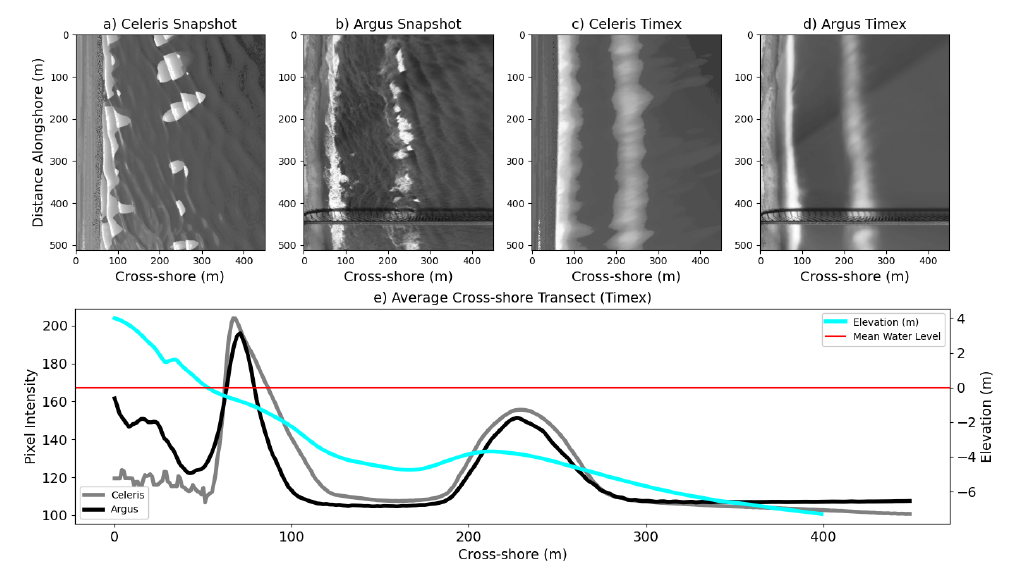
Figure 2. Comparison between synthetic imagery and HD video capture of the surf-zone. ( a ) Example snapshot of a Celeris visualization. ( b ) Example snapshot of the HD video. ( c ) Timex generated from the Celeris visualization. ( d ) Timex generated from the HD video. ( e ) Average cross-shore transect of the timex images in terms of pixel intensity, with the Celeris pixel intensity in grey, and the HD video in black. Along-shore averaged depth and the mean water level are shown on the right